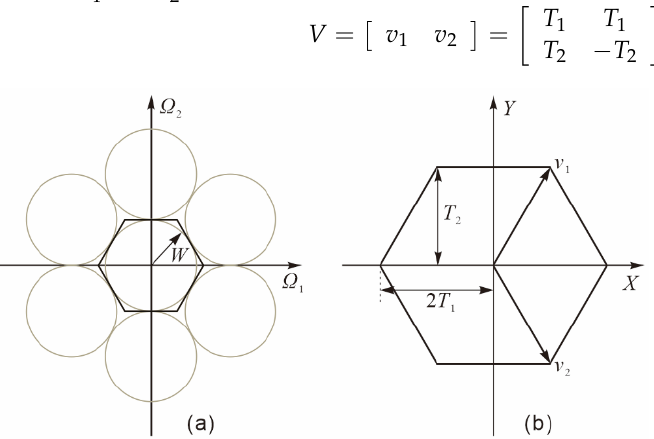
Figure 4. Schematic diagram of the spectrum and spatial sampling direction vector of the continuous signal after passing through the regular hexagonal sampling grid. ( a ) The frequency spectrum of the sampled signal. ( b ) Spatial sampling of 2 direction vectors.